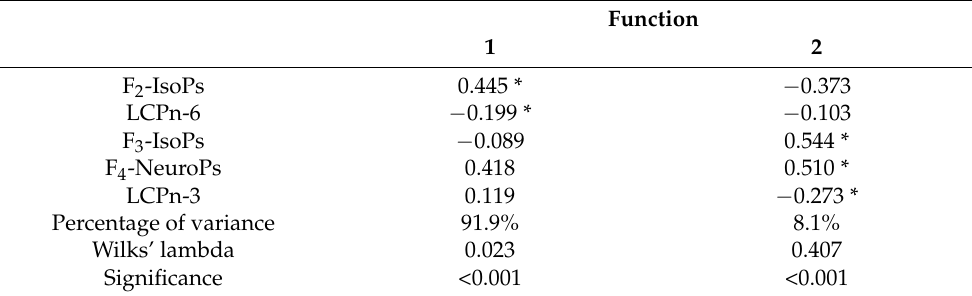
Table 4. Discriminant loadings of variables indicating lipids and isoprostanoids included in discrim- inant analysis 2 (DA2) with percentage of variance, Wilks’s lambda, and the significance of each discriminant